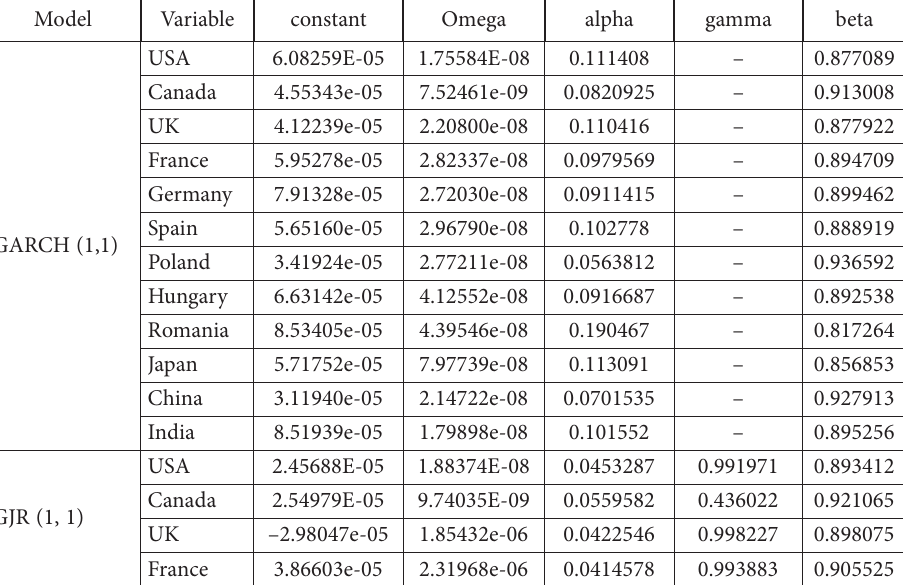
Table 4. Summary of GARCH family models (source: author’s computation)